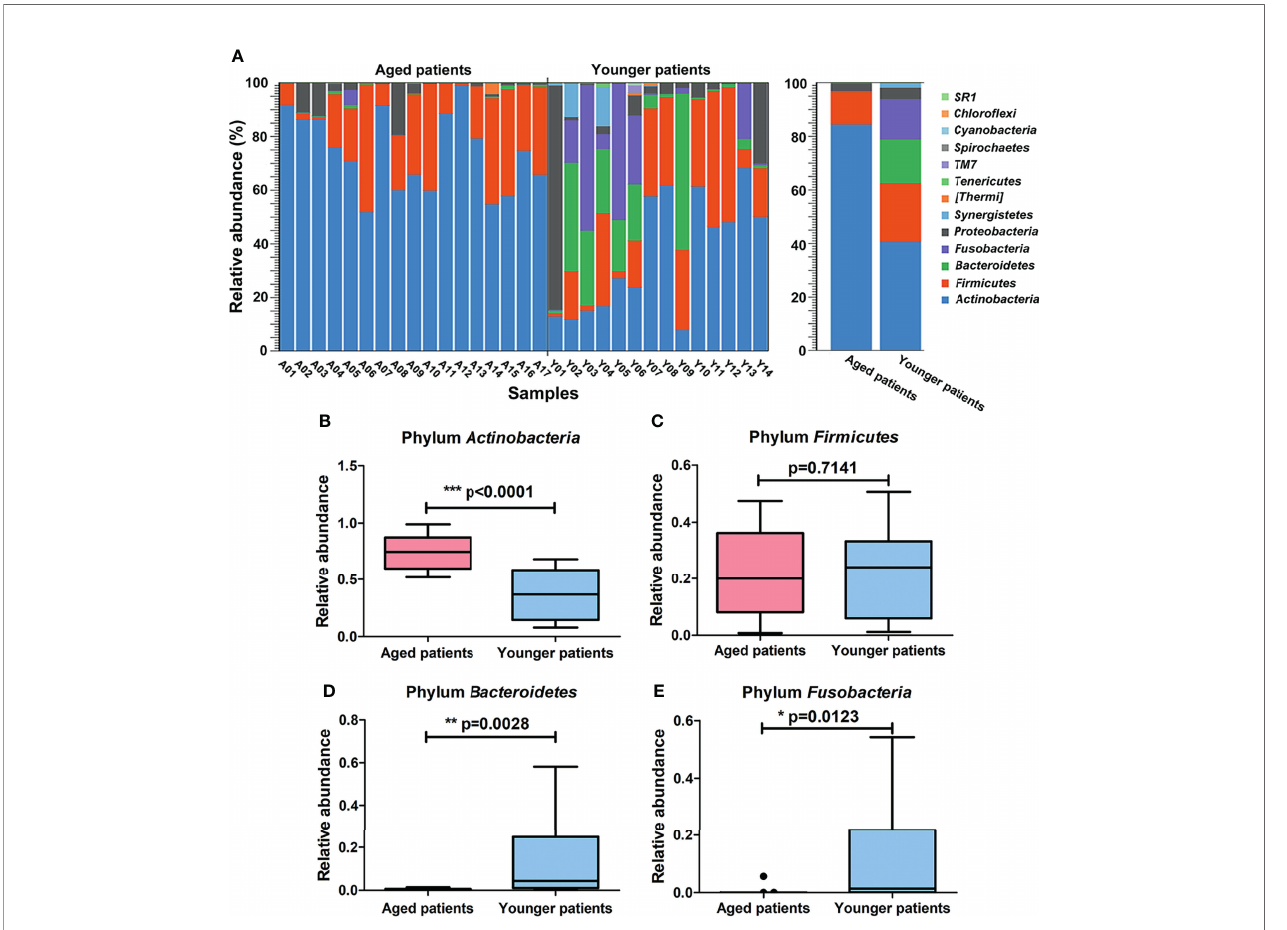
FIGURE 3 | Differences in composition of bacterial community at the phylum level between aged and younger patients. (A) Relative abundance (%) of bacterial taxa at phylum level of the nasal cavity of patients with CRS and comparison of bacterial abundance between aged and younger patients. (B – E) Mean Actinobacteria , Firmicutes , Bacteroidetes , and Fusobacteria abundance were compared between aged and younger patients. *p < 0.05, **p < 0.01, and ***p <